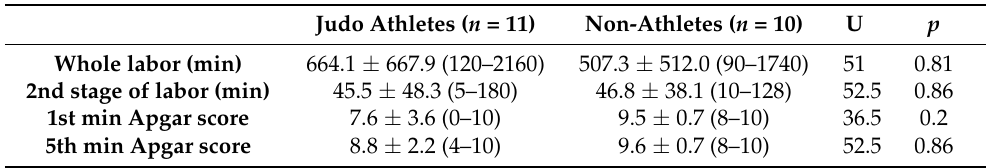
Table 4. Duration of labor and the neonate’s Apgar score in elite judo athletes and non -athletes with vaginal deliveries *.